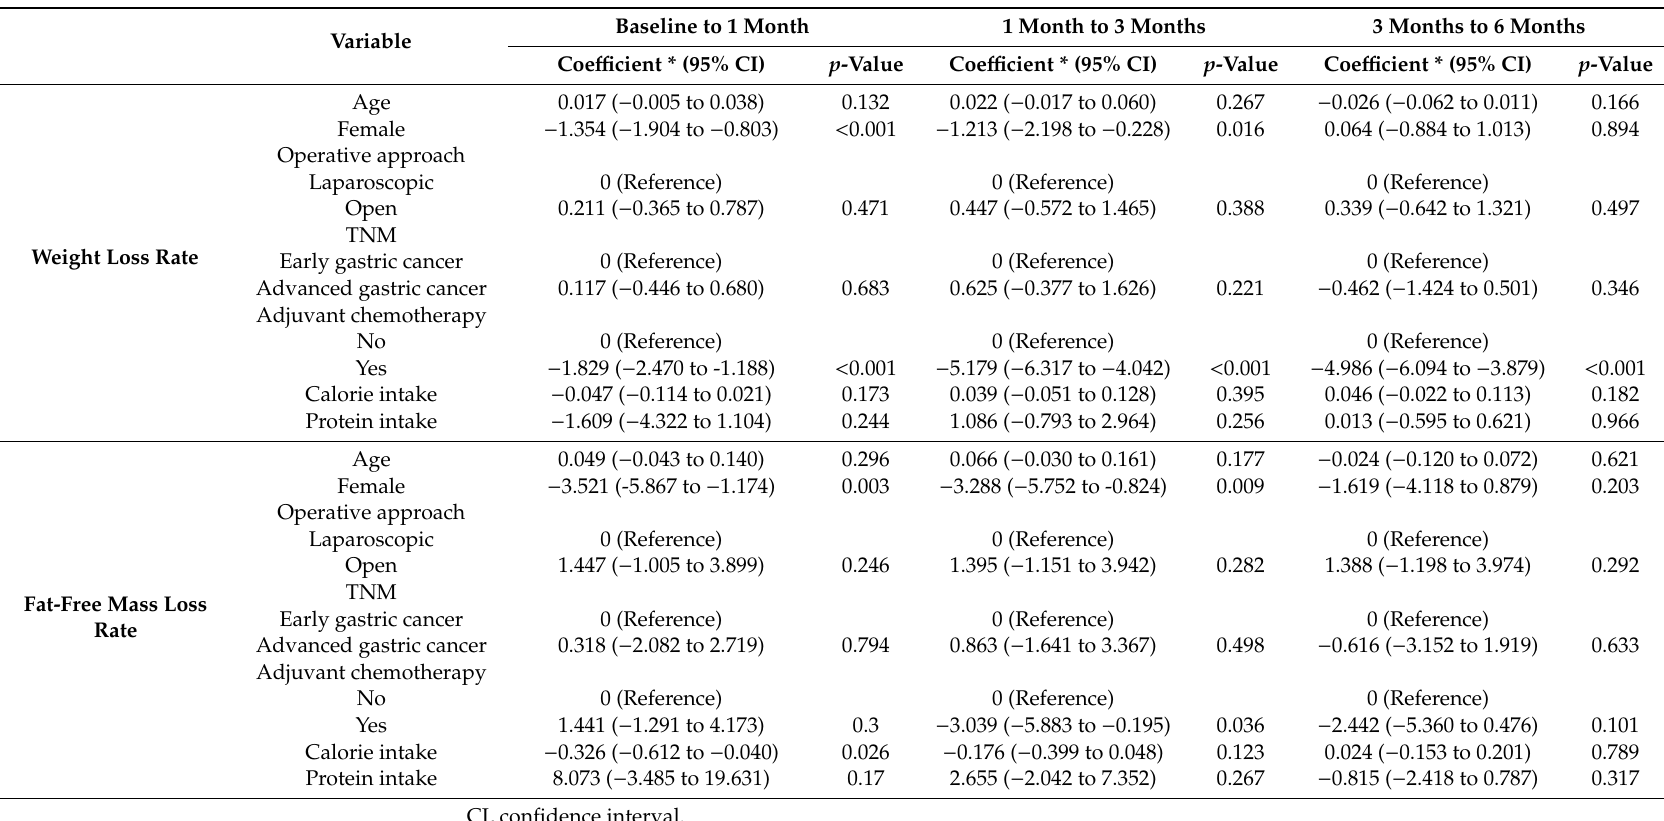
Table 5. Fitting the multiple linear regression models for the clinical factor and weight / FFM loss rate after